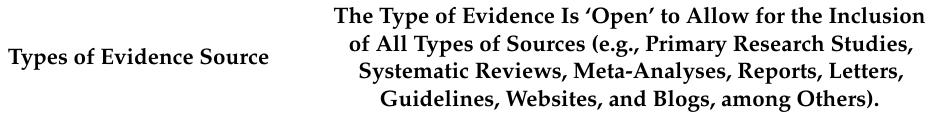
Table 1. Scoping review inclusion